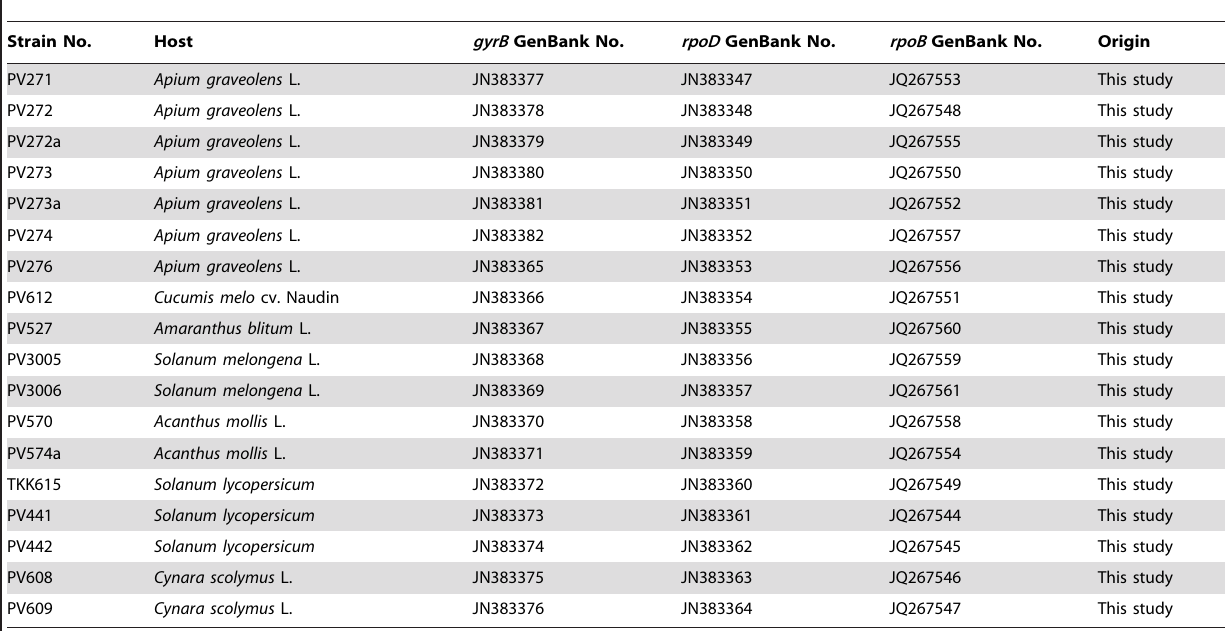
Table 4. Local bacterial strains used in this study for gyrB , rpoD and rpoB phylogenetic analysis.